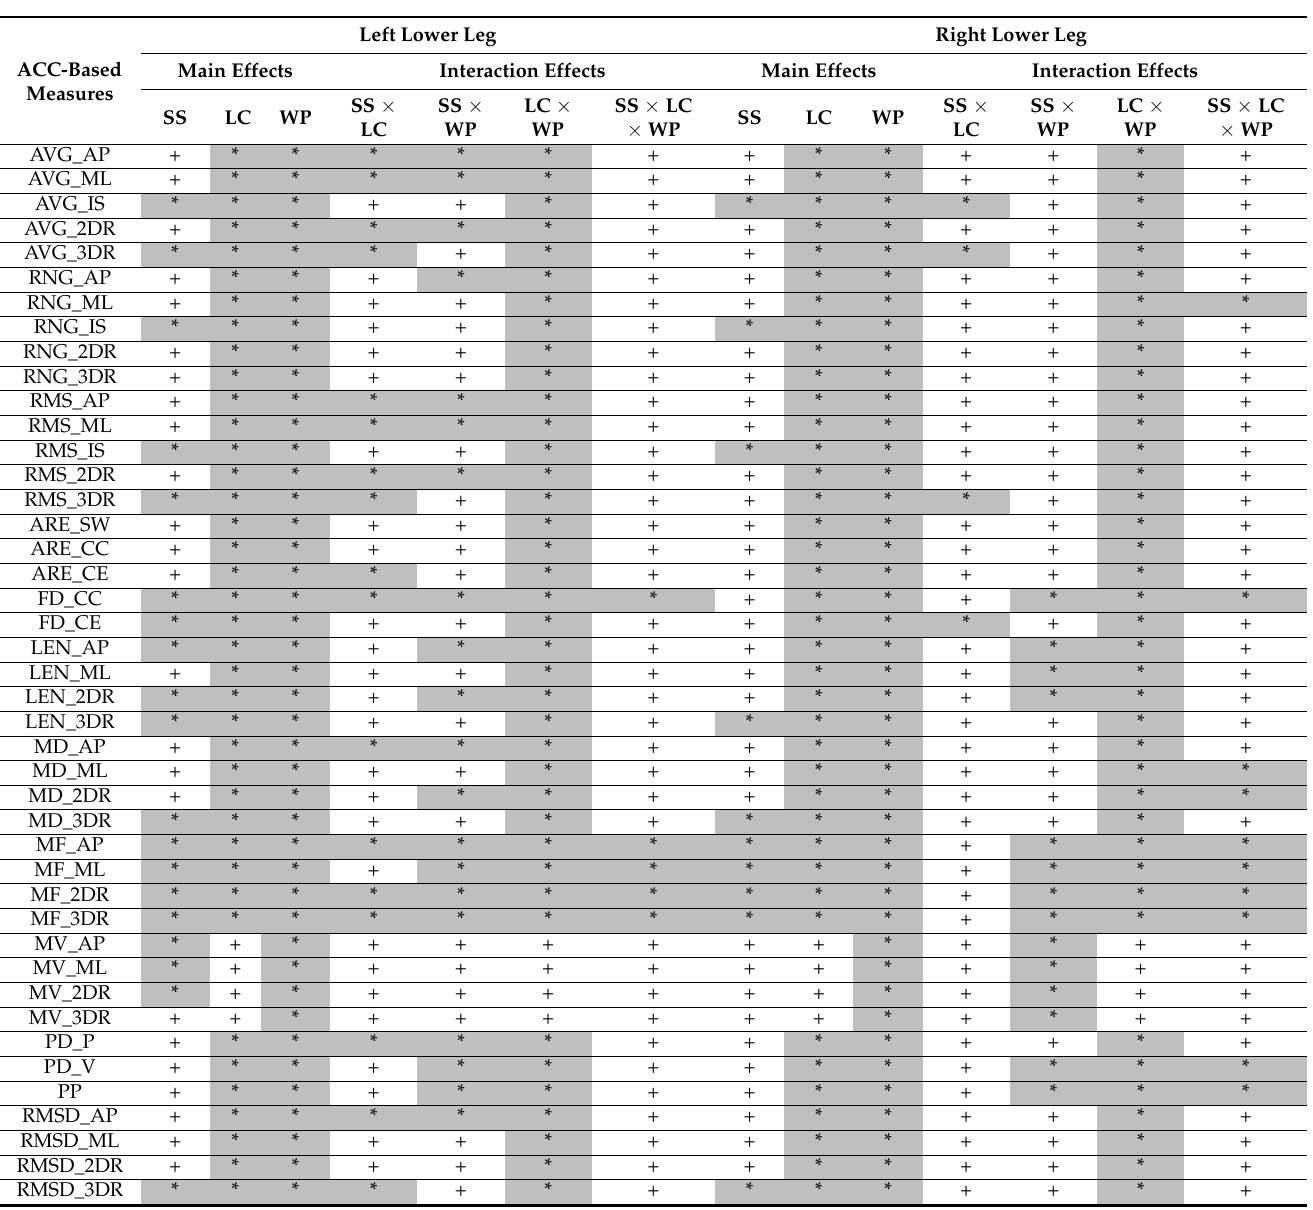
Table A4. Results 1 of t -tests and Analysis of variance using the acceleration data of Lower